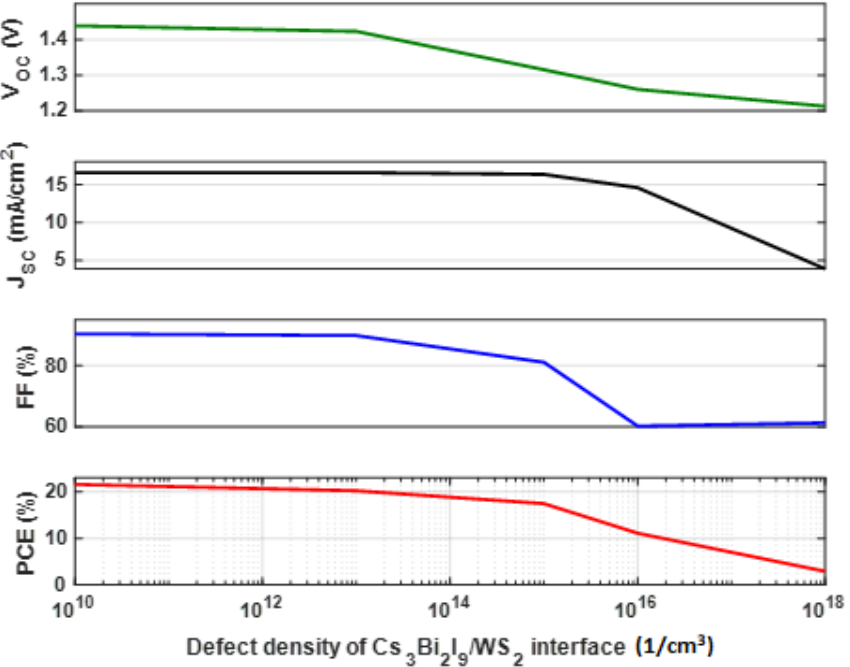
Figure 11. Effect of defect density of Cs 3 Bi 2 I 9 /WS 2 interface on the performance parameters.